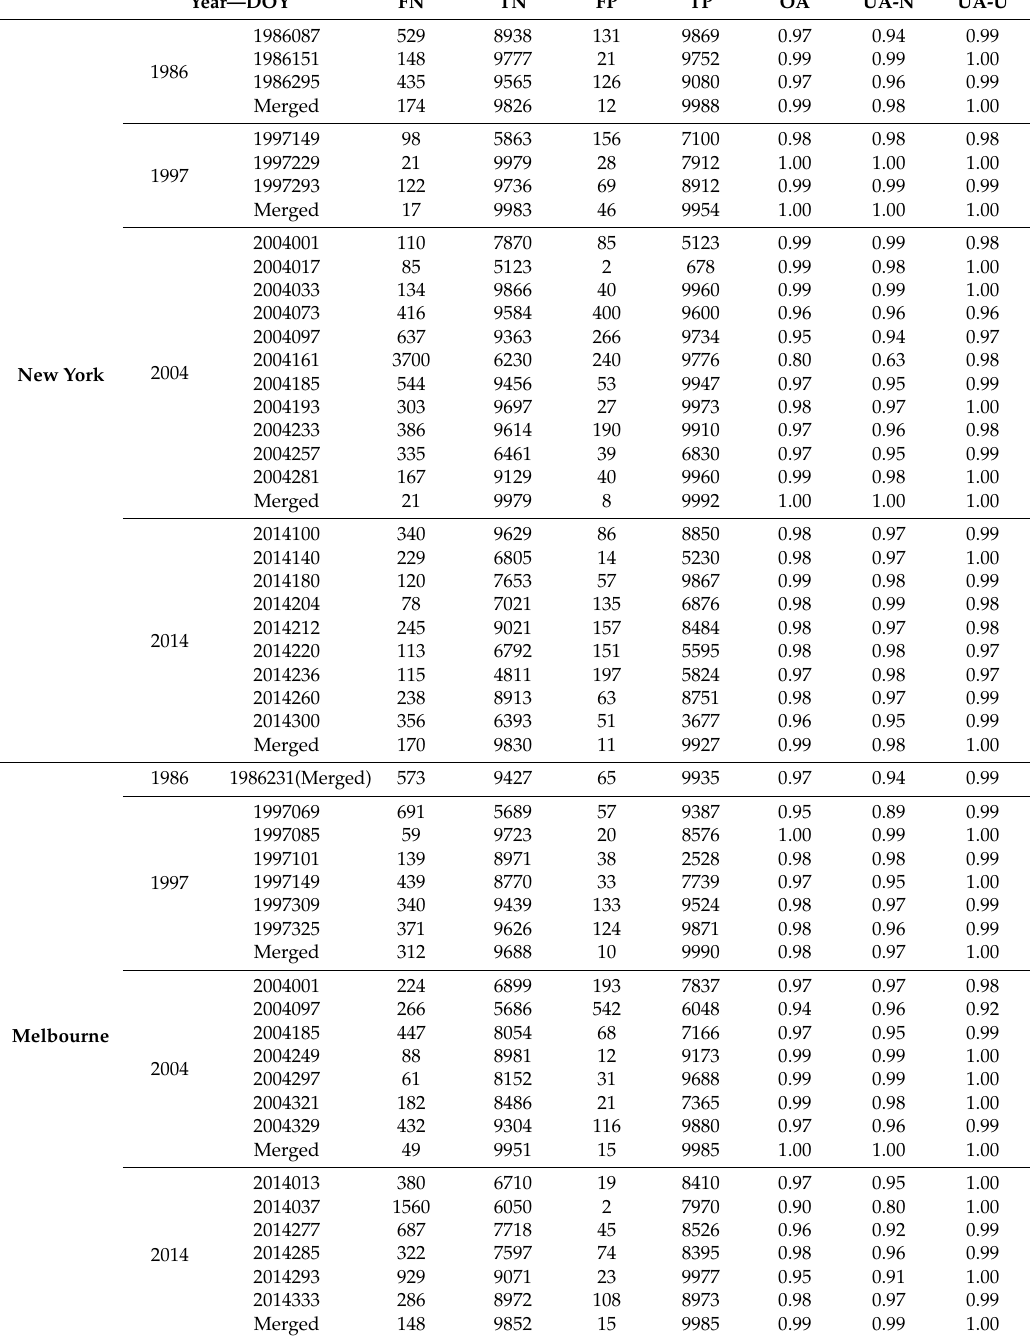
Table 2. Classification performance for each study areas in specific years (see text for